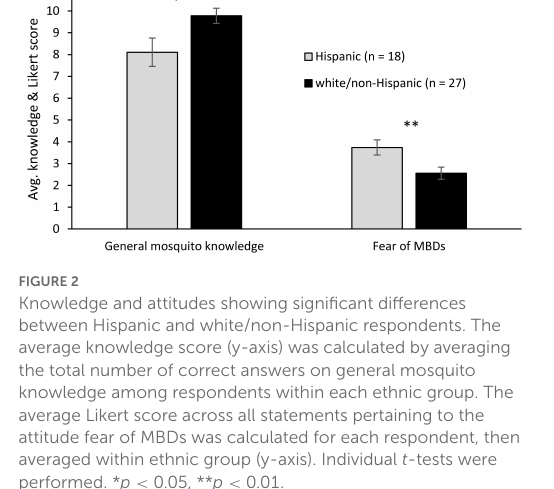
Practices and premise condition index Coefficient of correlation (P -value) Wears Uses insect protective repellant clothing